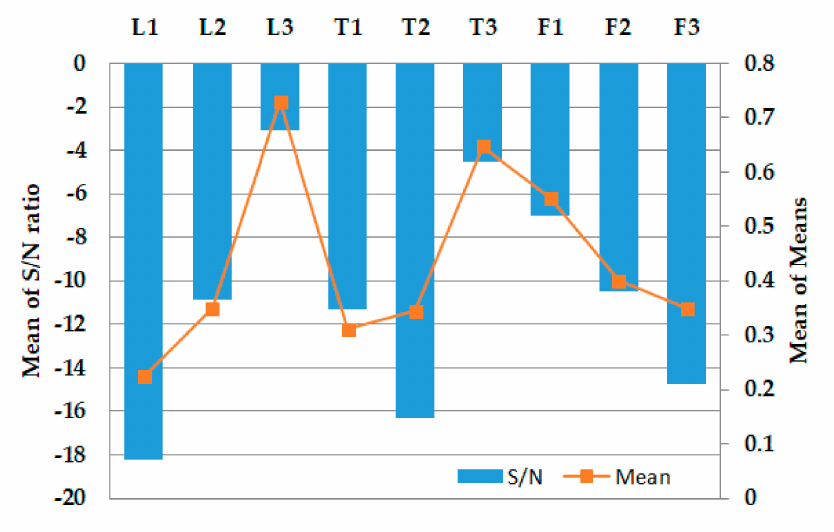
Figure 9. The main e ff ect plot for Mean and S / N ratios.